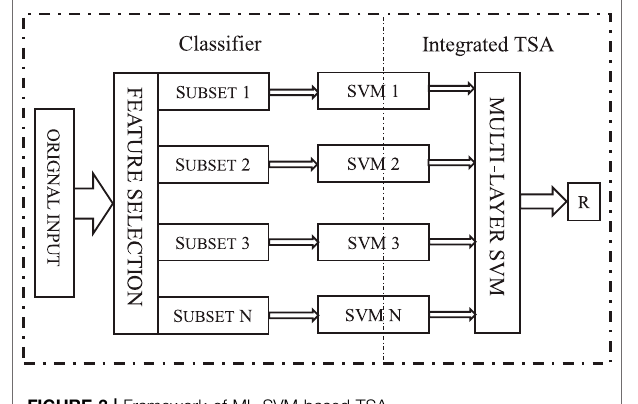
FIGURE 3 | Framework of ML-SVM based TSA.